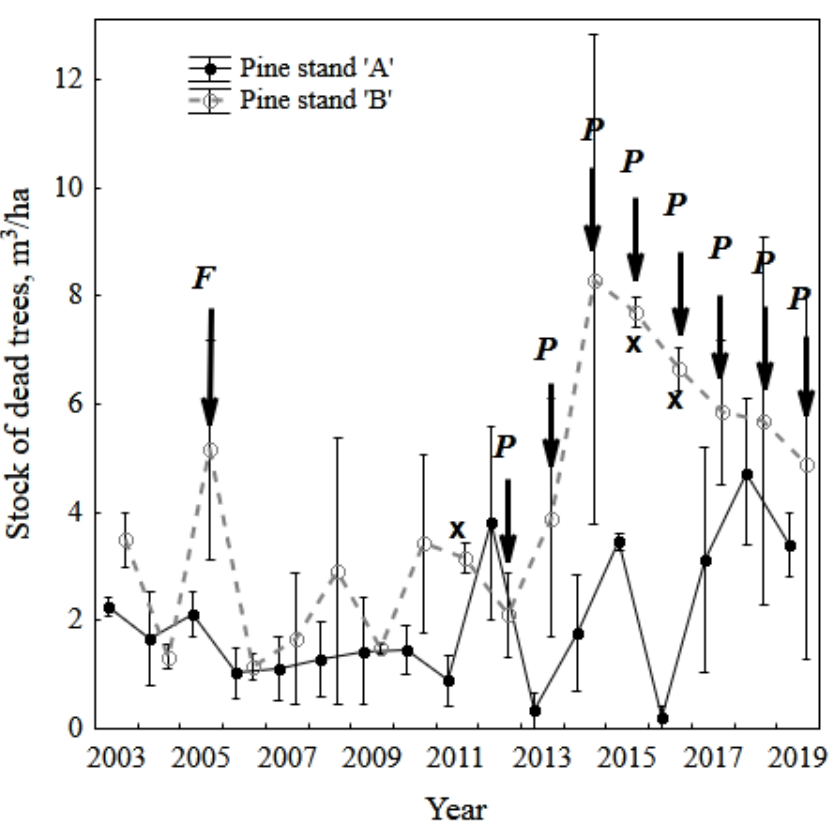
Figure 5. Stock of trees which died in 2002–2019. Acute or chronic impacts on the stands were caused by the thermal factor ( F , a creeping fire) or chemical factor ( P , pollutants), respectively. “X“ marks a significant difference between pine stands ‘A’ and ‘B’ ( p <0.05 by the t -test). Average values for 2–3 permanent sample plots and their standard errors are shown.